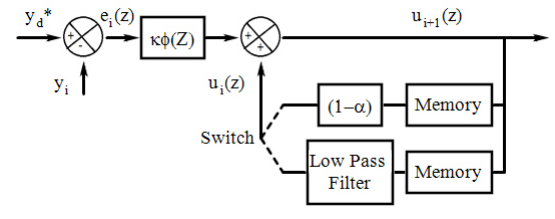
Figure 9. ILC with low pass